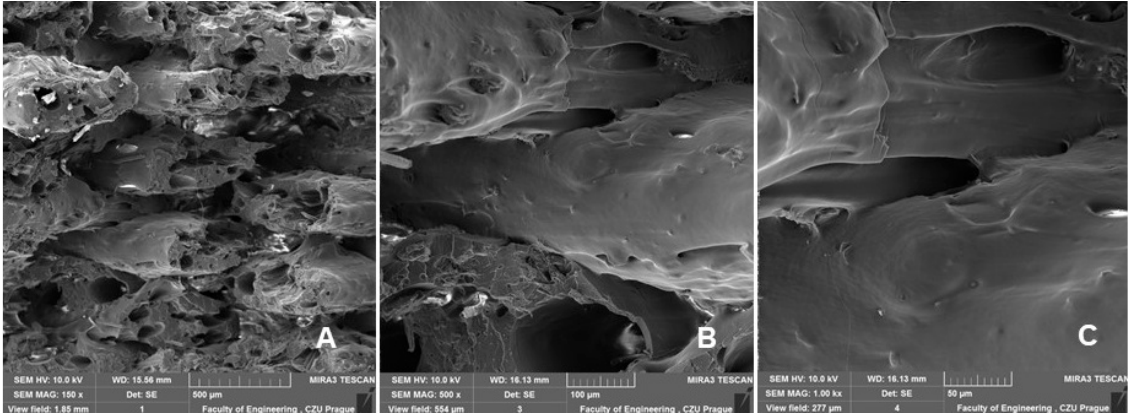
Figure 12. SEM images—fractographic analysis—nozzle 0.4 mm, infill density 60%, low cyclic fatigue—connection of individual layers, arrangements, and their porosities: ( A ): MAG 150×; ( B ): MAG 500×; ( C ): MAG 1.00 kx.